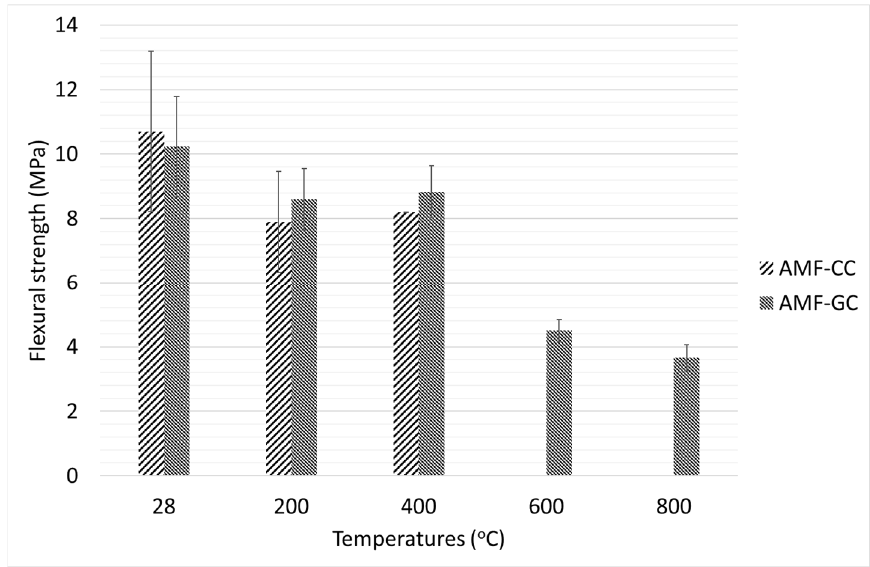
Figure 9. Flexural strength of AMF reinforced cement and geopolymer concrete.